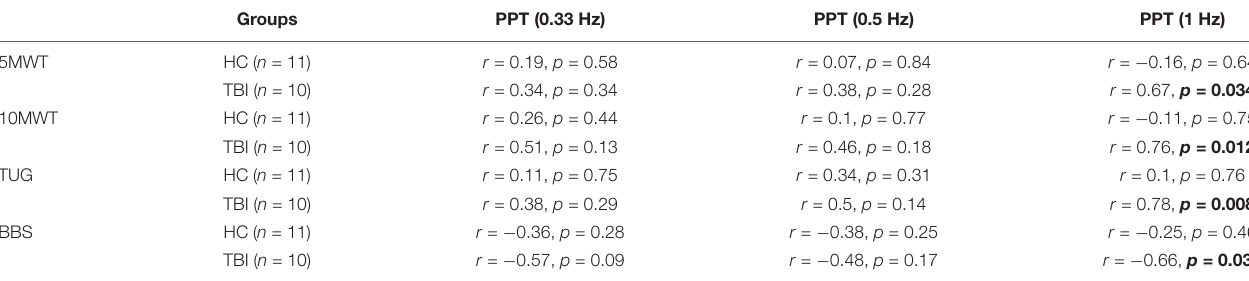
FIGURE 4 | Demonstration of a linear relationship between the PPT (1 Hz) and time required to complete (A) 5MWT, (B) 10MWT, (C) TUG, and (D) scores for the BBS for the TBI group. No significant correlations were found for the HC group PPT data for all three frequencies. Also, no correlations were found for the 0.33 Hz and 0.5 Hz PPT data for the TBI group as reported in Table 4 . TABLE 4 | Results of Pearson’s r correlation analysis between PPT and functional outcomes for both groups. Groups PPT (0.33